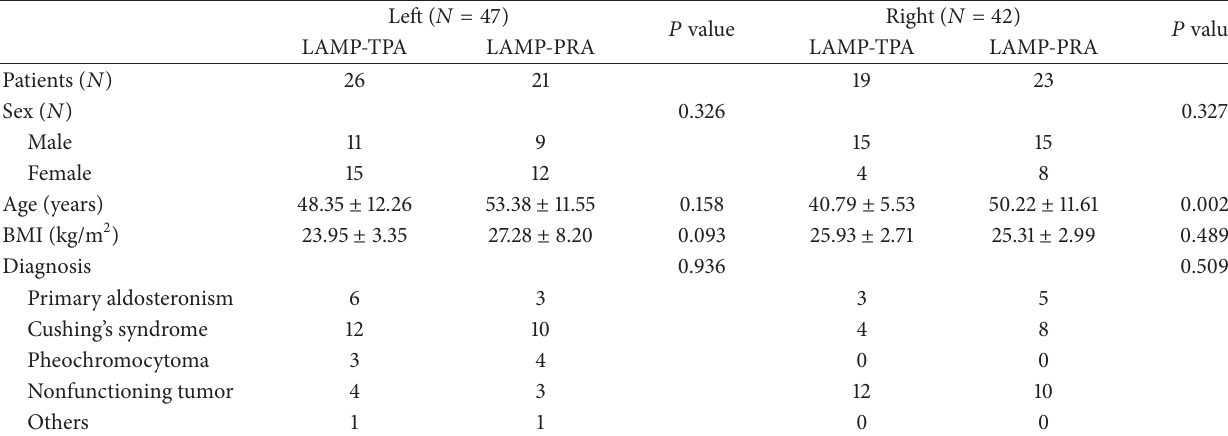
Table 1: Patient characteristics.